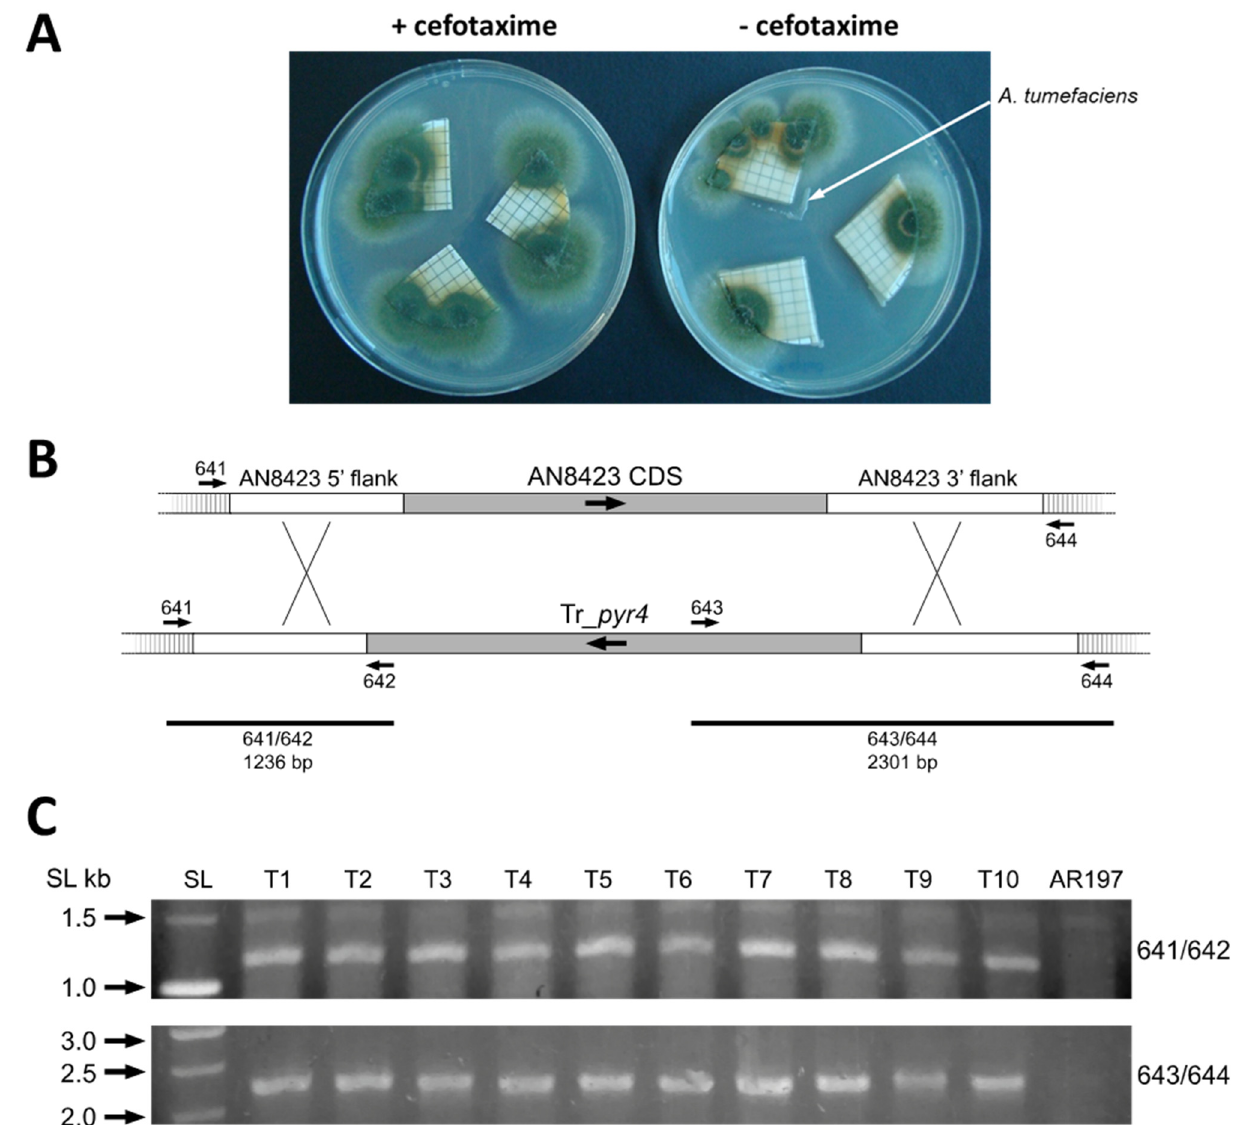
Figure 3. Deletion of AN8423. ( A ) Growth of A. nidulans ATM transformants in the presence or absence of cefatoxime. A. nidulans conidia at a titre of 10 8 per mL were used for co-culture. ( B ) Scheme showing replacement of the AN8423 CDS by the Tr_ pyr4 expression cassette. ( C ) Diagnostic PCR with primer pairs 641/642 and 643/644 yields fragments of the sizes predicted for replacement of locus AN8423 by Tr_ pyr4 . SL: Smart Ladder (Promega, Madison, WI, USA).